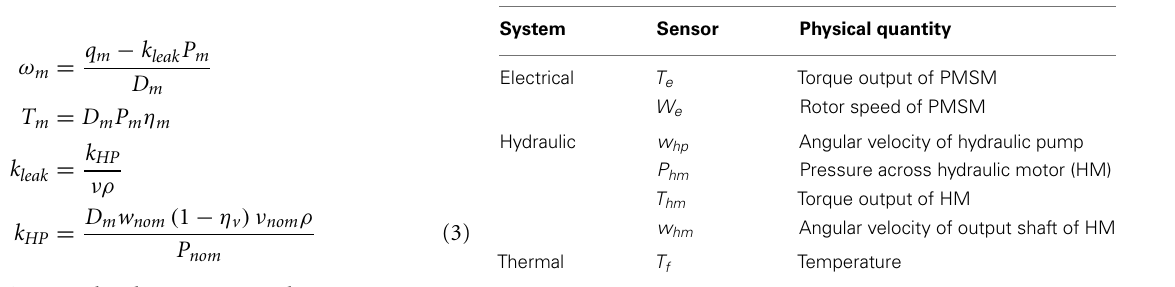
Table 1 | Sensors of the system .